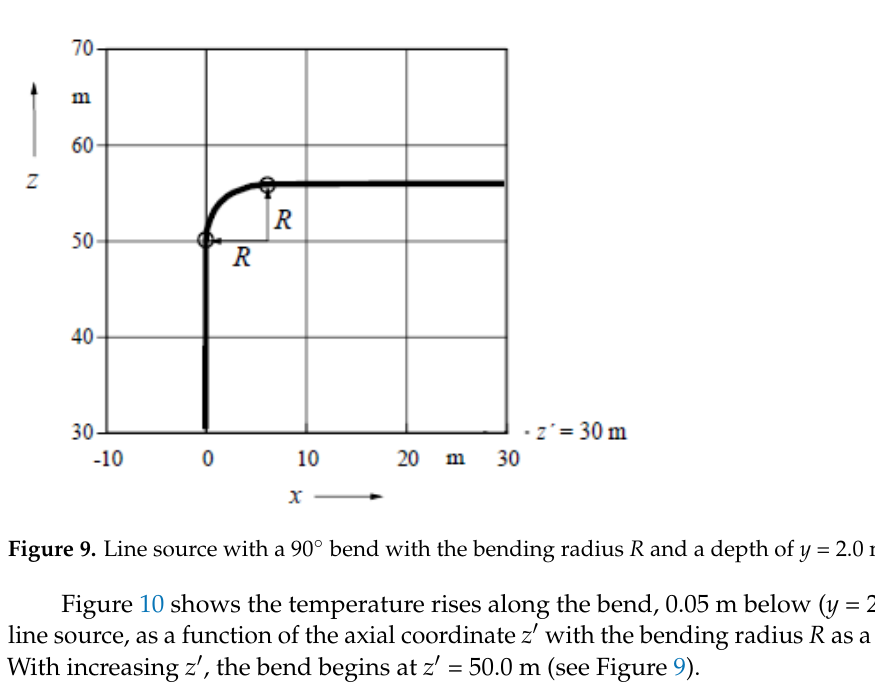
9 of 19 Figure 8. Thermal response at a point with Δ y = 0.05 m to a finite line of point sources with loss steps of 100 W/m and 150 W/m, as defined in Figure 7. 3.2. Line Source with a 90° Bend